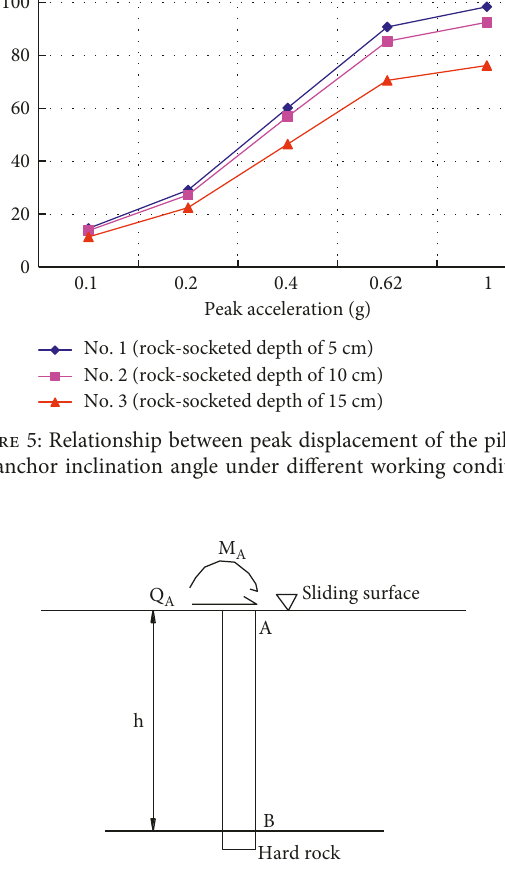
Figure 6: Schematic diagram of a hinged anti-slide pile. Table 3: The axial strain peaks and peak displacement of anchor pile under different working conditions.